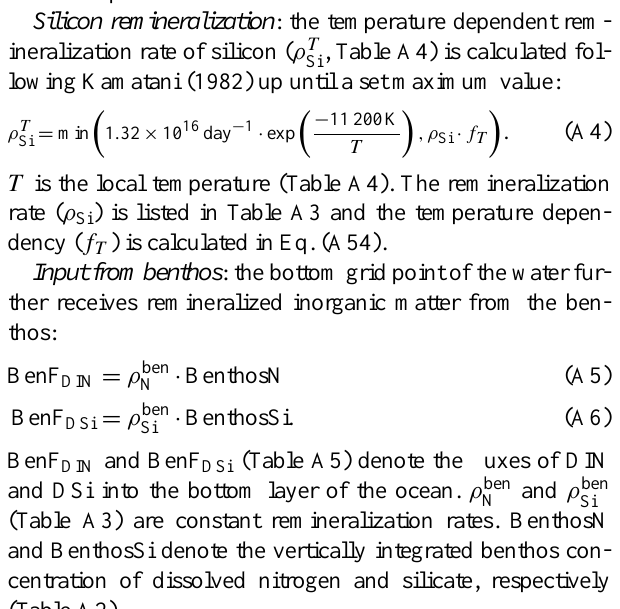
and (cid:15) zoo ) and the degra- C C